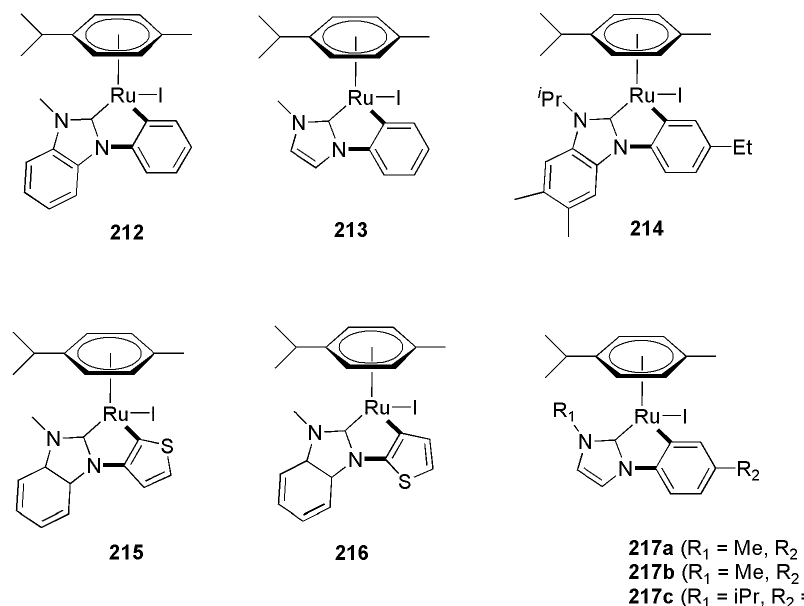
Figure 28. Bidentate C NHC ‐ C ‐ based ligands introduced by Verpoort et al. [199].